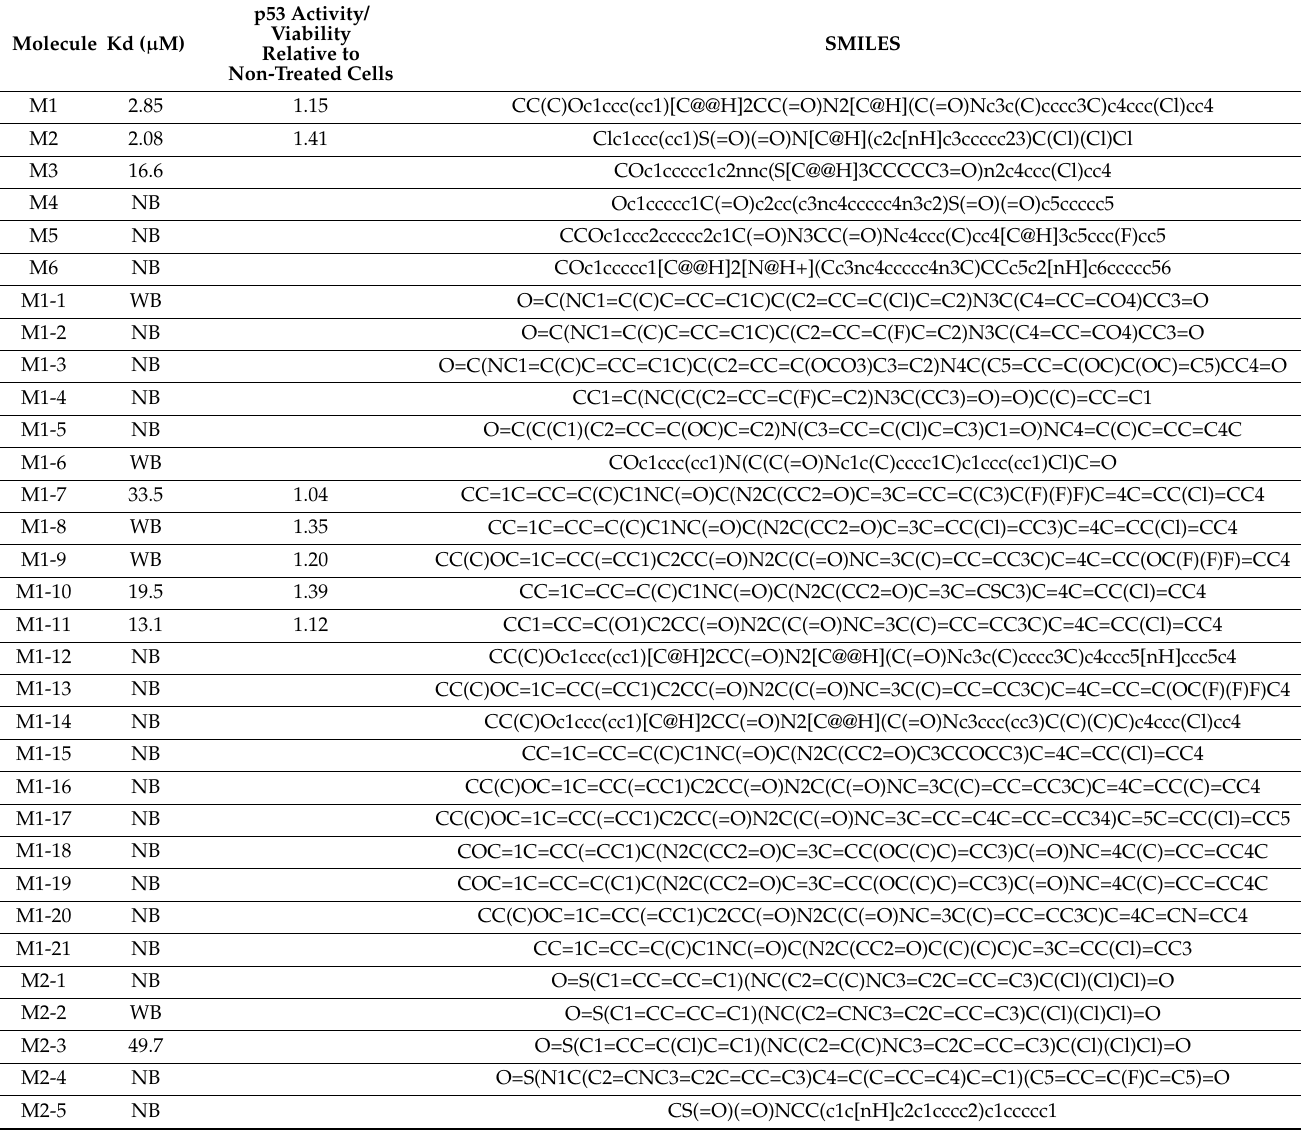
Figure 6. Cellular activity. A bar plot showing the fold activity of p53 in MCF7 cells treated with 15 µM of the molecules. The red line marks a 25% increase in activity. Table 1. Molecule parameters.